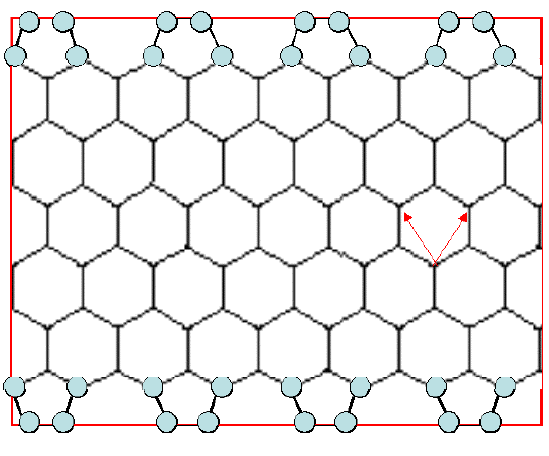
Figure 6. Modification of the graphene sheet to generate a zipper NT.